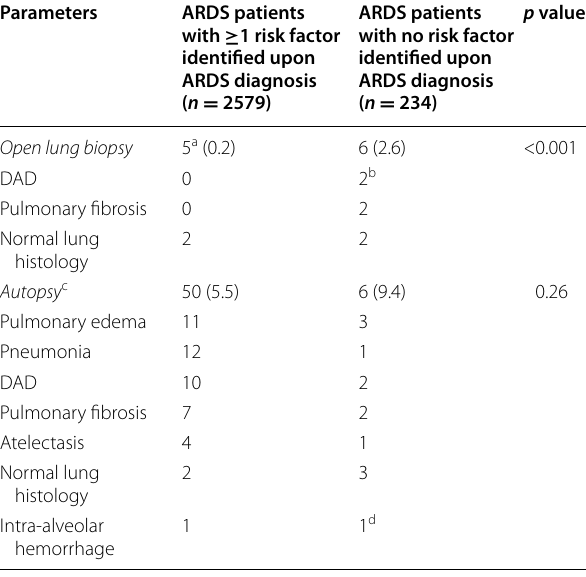
Table 4 Lung histological analysis results obtained from open lung biopsy or autopsy in patients with and without ARDS risk factor